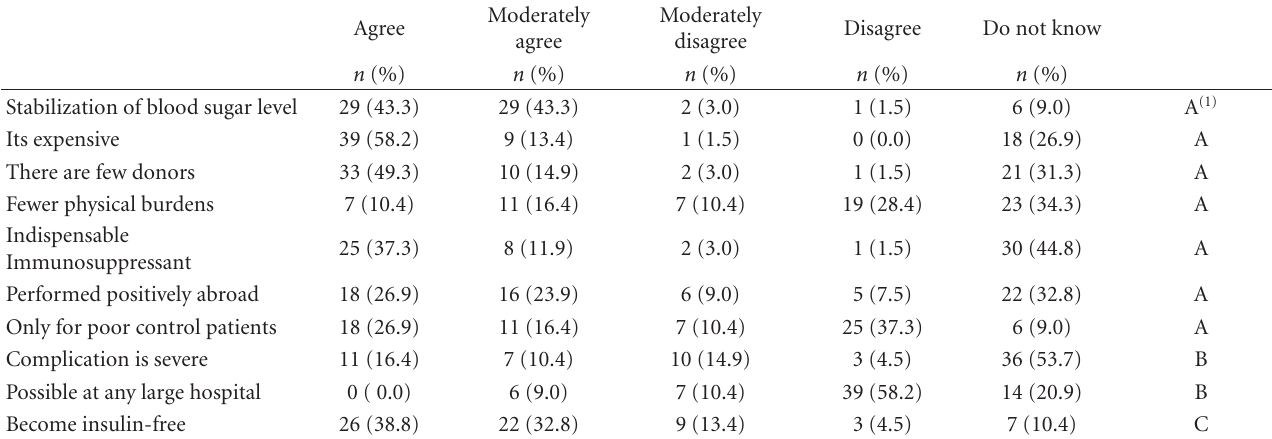
Table 3: Detailed perception of islet transplantation ( N = 67).